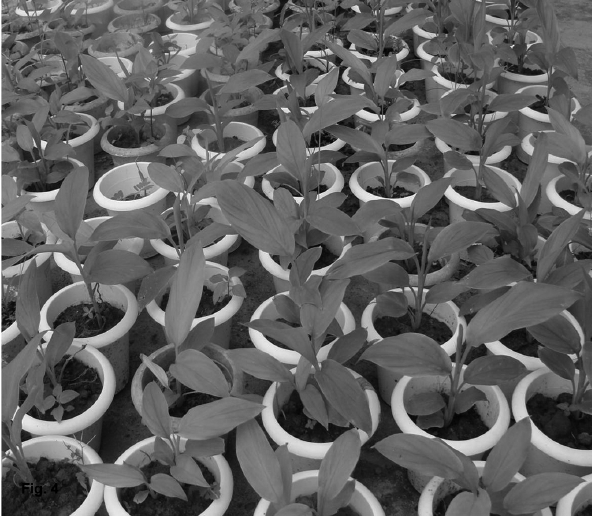
Fig. 4. Established plants with the presence of Silver nitrate in shade house